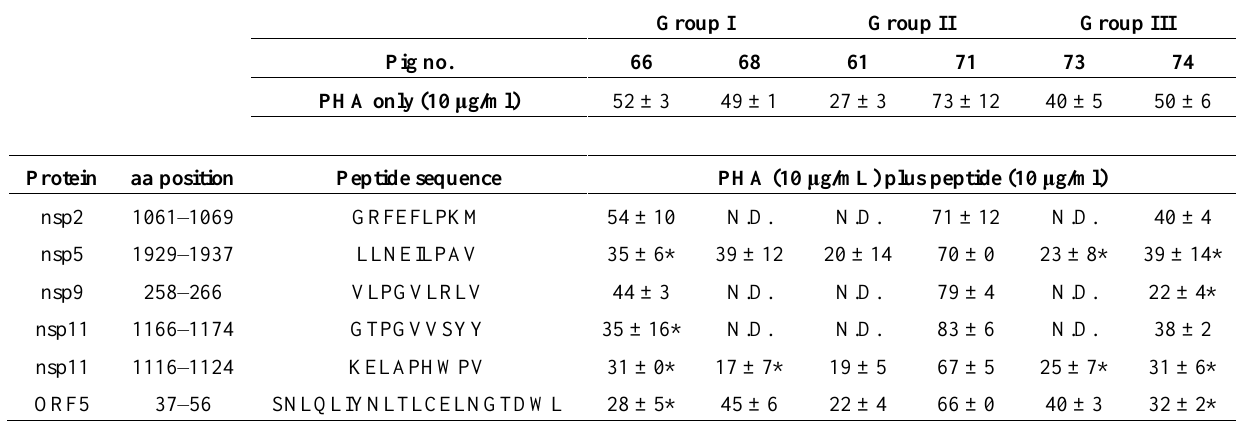
Table 5. Effect of the addition of selected peptides to PHA-stimulated cultures on the frequency of IFN-γ secreting cells (per 5x10 4 cells) of PBMC as determined in